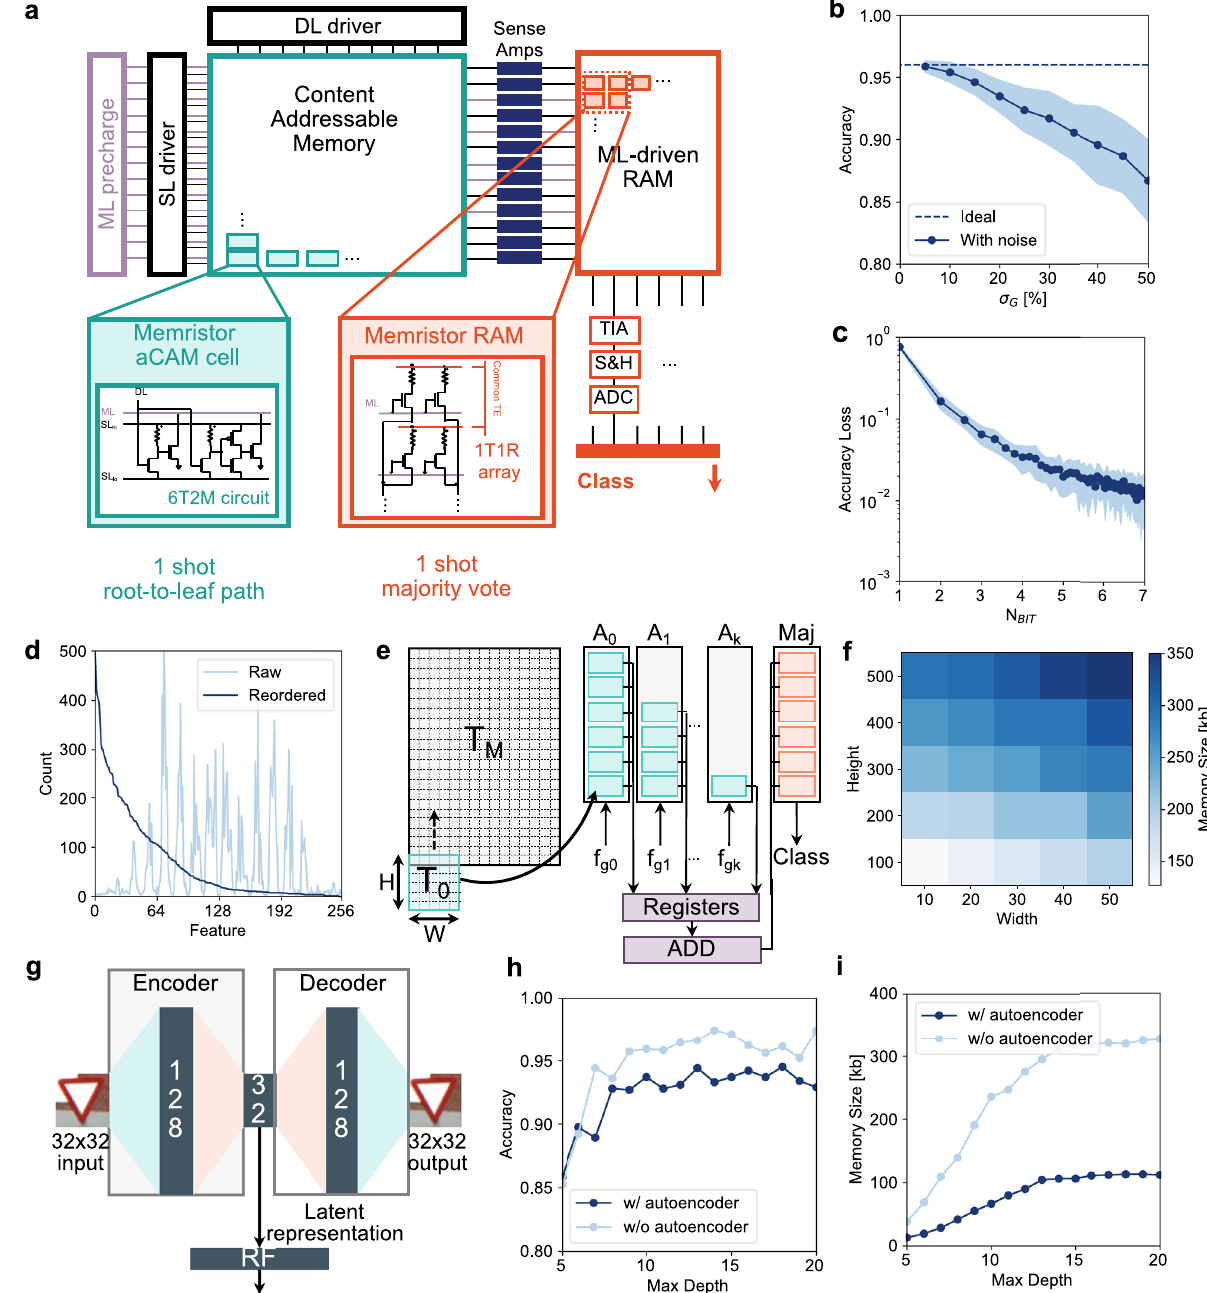
Fig. 4 RF accelerator architecture. a Overview of the full IMC system, with analog CAM executing root-to-leaf evaluation in one step and 1T1R RRAM array executing the majority vote in the analog domain. b Accuracy as a function of the standard deviation of injected noise σ G in the programmed conductance for 100 different experiments, fi lled line represent the average while bands correspond to the standard deviation. c Accuracy loss as a function of the number of bit for representing the threshold in 10 RF trained on the dataset, fi lled line represent the average while band the standard deviation. d The number of populated (non `X') analog CAM cells in the arrays as a function of the feature index for a direct mapping (raw, light blue line) and reordered array (blue line). e Tiles and array mapping procedure, the threshold map TH Map traversed from bottom to top and from left to right by H × W tiles ( T 0 in the example), which are fi lled in the presence of valid rows, namely rows that are not completely empty. Once a tile is full, it is placed in the corresponding array ( A 0 ) in the example, which will evaluate a group of W features from the feature vector. f Memory size needed as a function of tile height H and width W . g Schematic of variational autoencoder architecture for compressing the dataset a 32 wide feature vector. h Accuracy as a function of maximum depth in the RF with and without autoencoder as input. i Memory size required as a function of maximum depth in the RF with and without autoencoder as